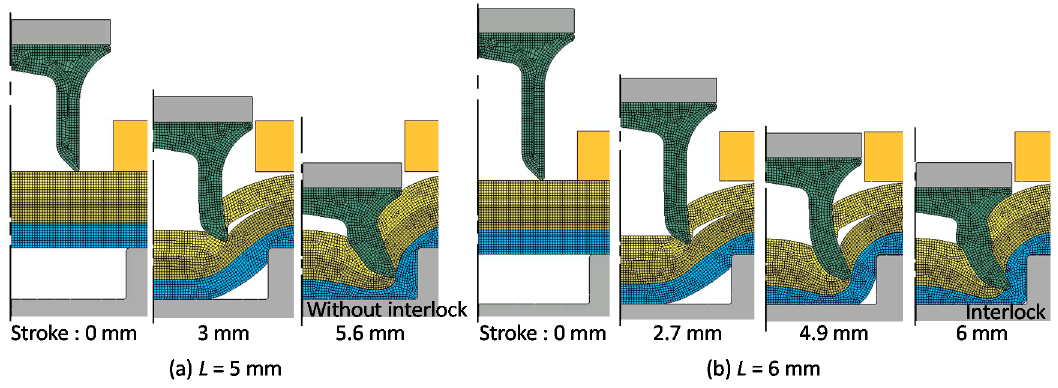
Figure 11. Calculated deforming behaviors of sheets and rivet for D = 9 mm and H = 2 mm, ( a ) L = 5 mm; ( b ) L = 6 mm.